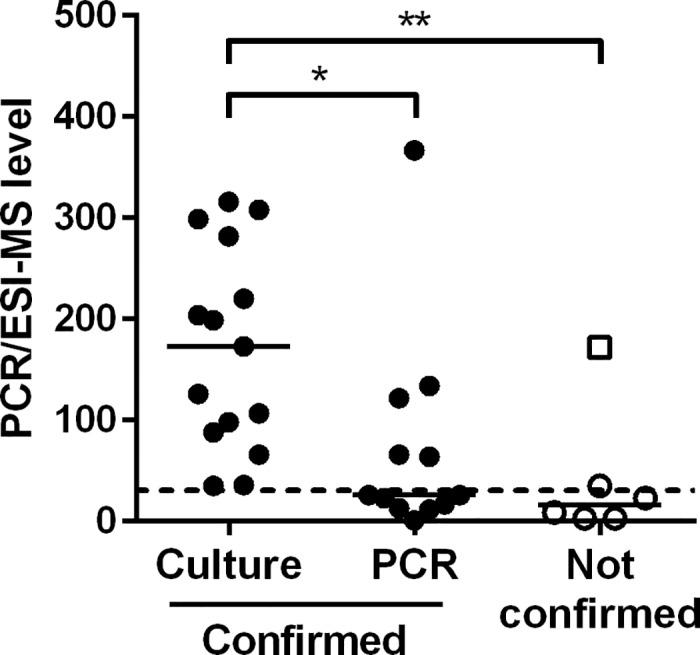
Semi-quantitative detection of Staphylococcus aureus by PCR/ESI-MS.S. aureus was detected in a total of 33 bronchoalveolar lavage samples. In 27 samples, the results were confirmed by culture (n = 15) or PCR for nuc (n = 12). Individual values with median are shown, comparison was made by Kruskal-Wallis with Dunn’s multiple comparison post-test; *P<0.05, **P<0.01. The dashed line indicates the mean level for the lower detection limit of S. aureus by PCR/ESI-MS (0.4×104 CFU/ml), the open square indicates a sample not available for confirming tests.